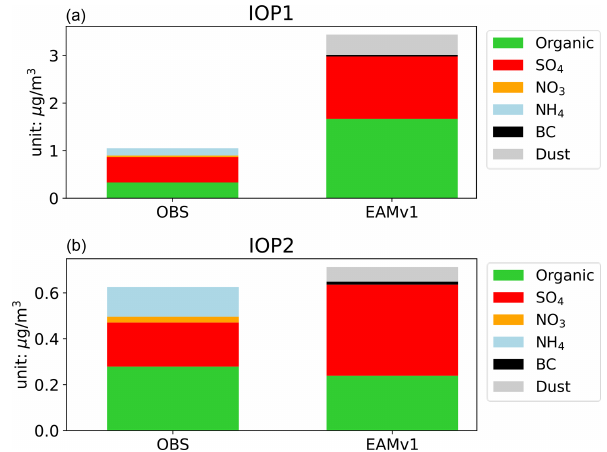
Figure 10. Same as Fig. 8 but for